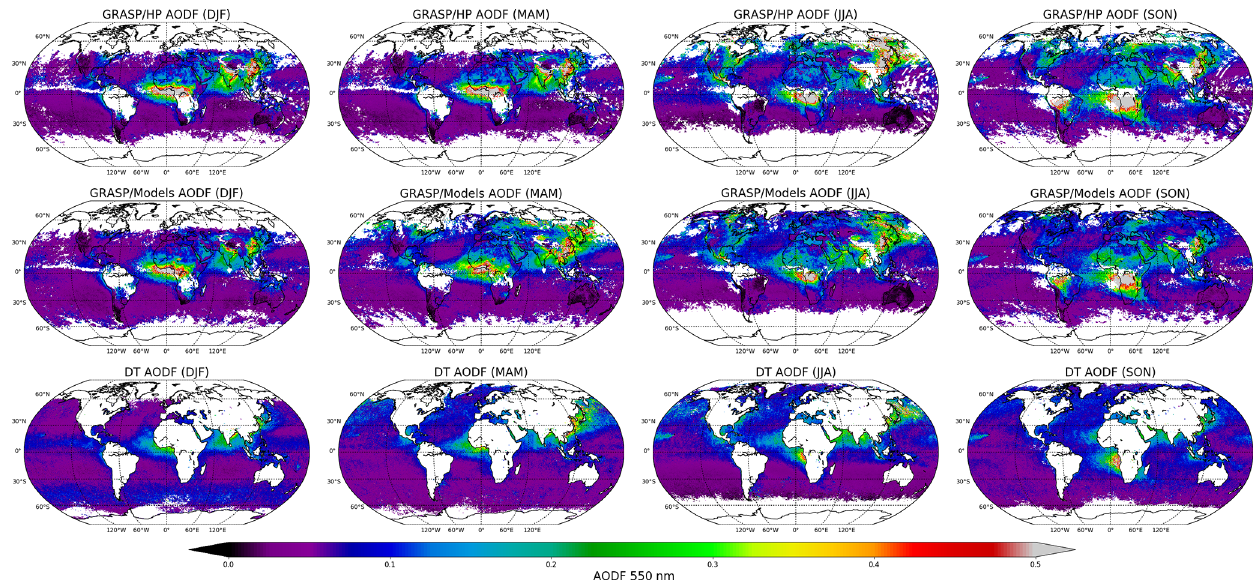
Figure 25. Spatial distribution of 0.1 ◦ × 0.1 ◦ seasonal AODF (550nm) from PARASOL (GRASP/HP and GRASP/Models) and MODIS (DT) products.